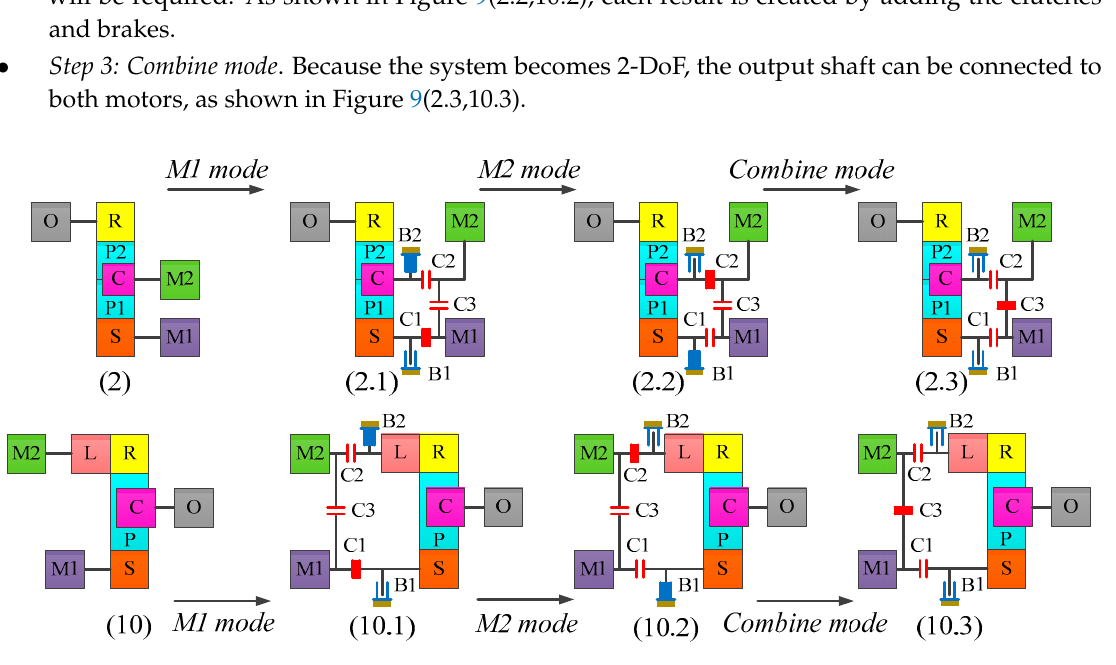
Figure 9. Process of clutch arrangement.